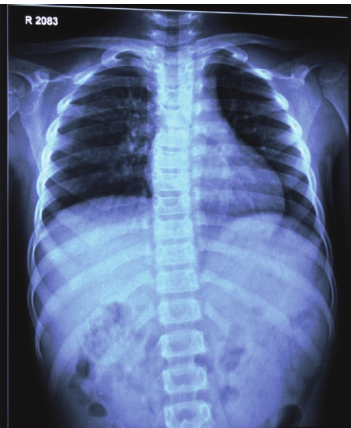
Figure 6: Chest radiograph.